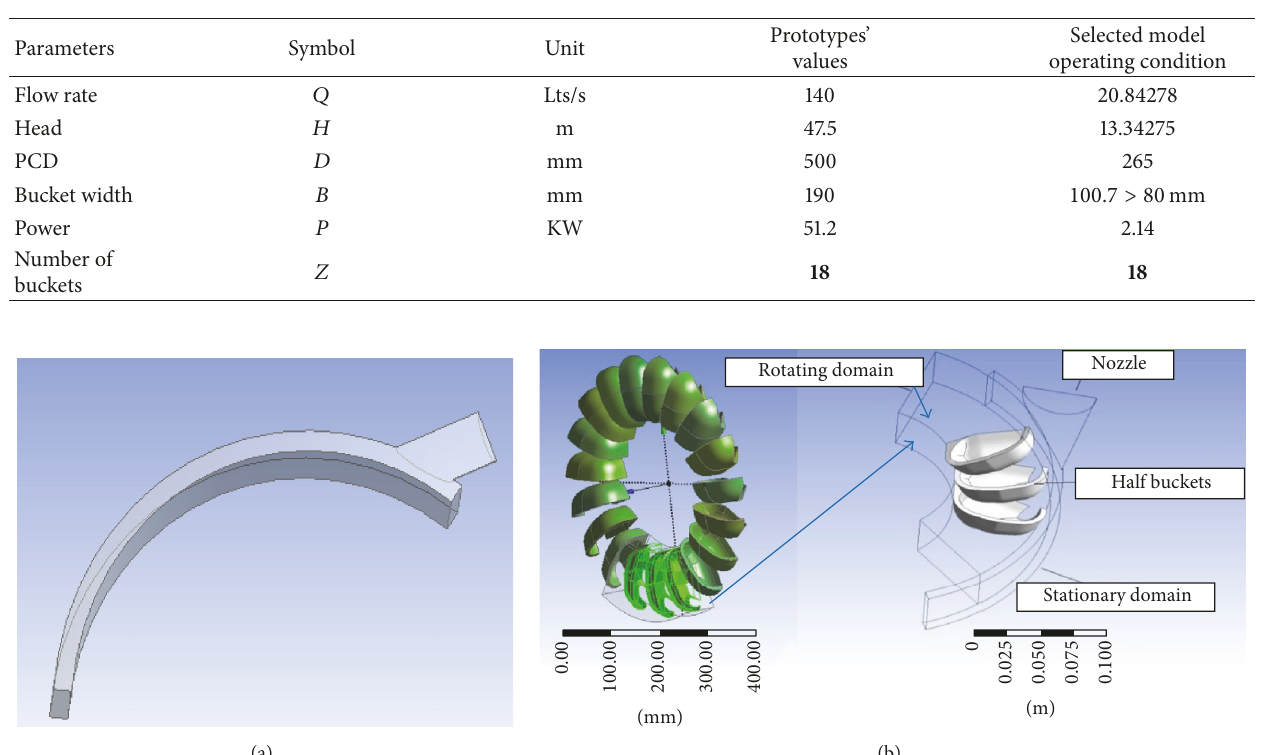
Table 7: Turbine geometry and setup values for prototype and model.